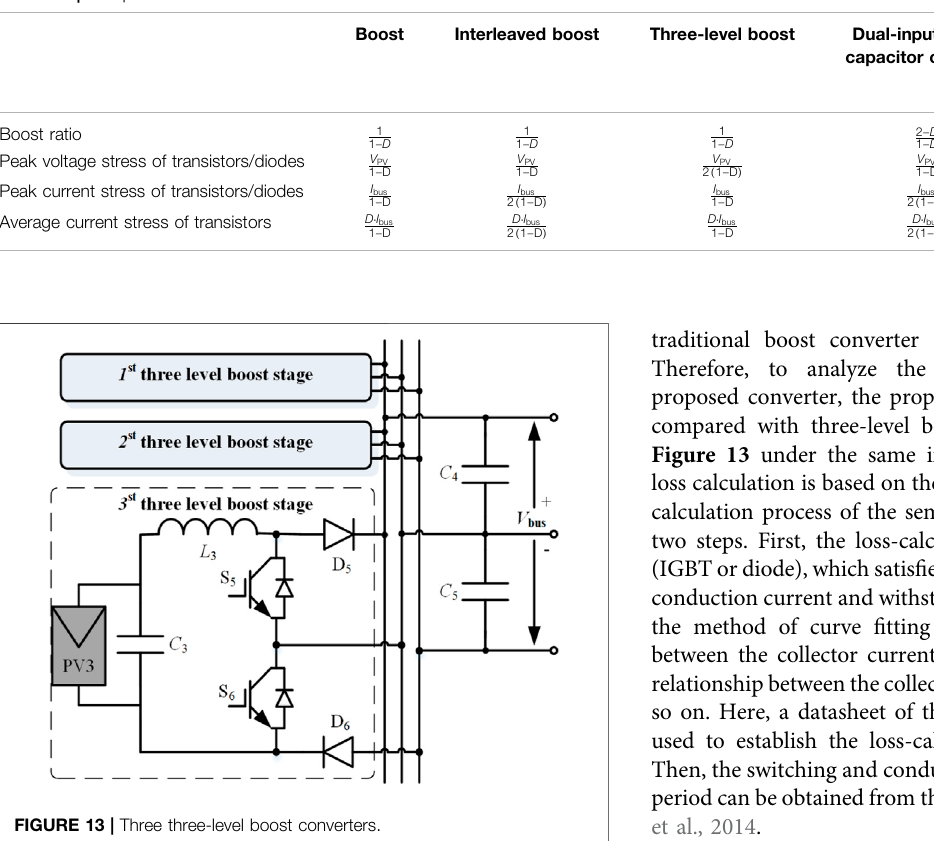
FIGURE 13 | Three three-level boost